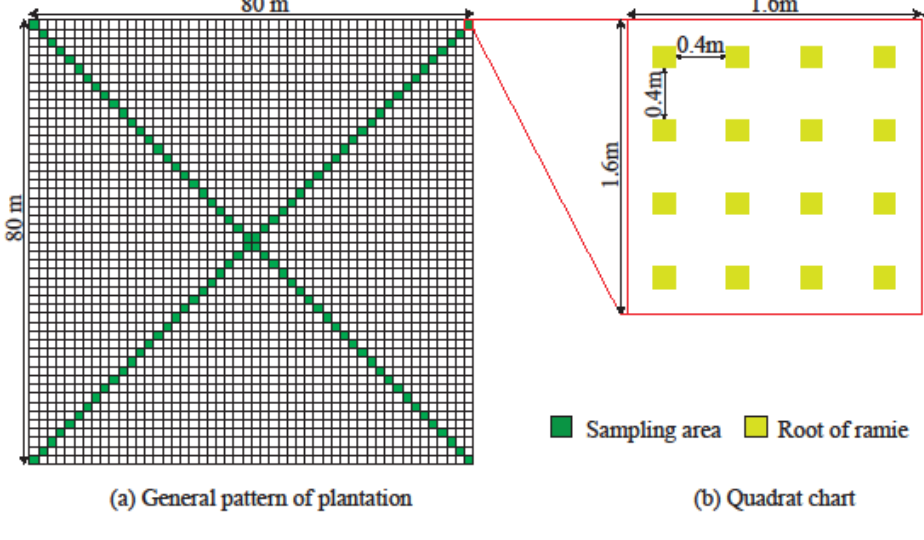
Figure 1. Ramie planting map.